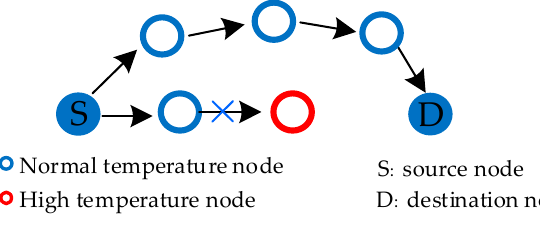
Figure 6. Temperature-sensing routing.